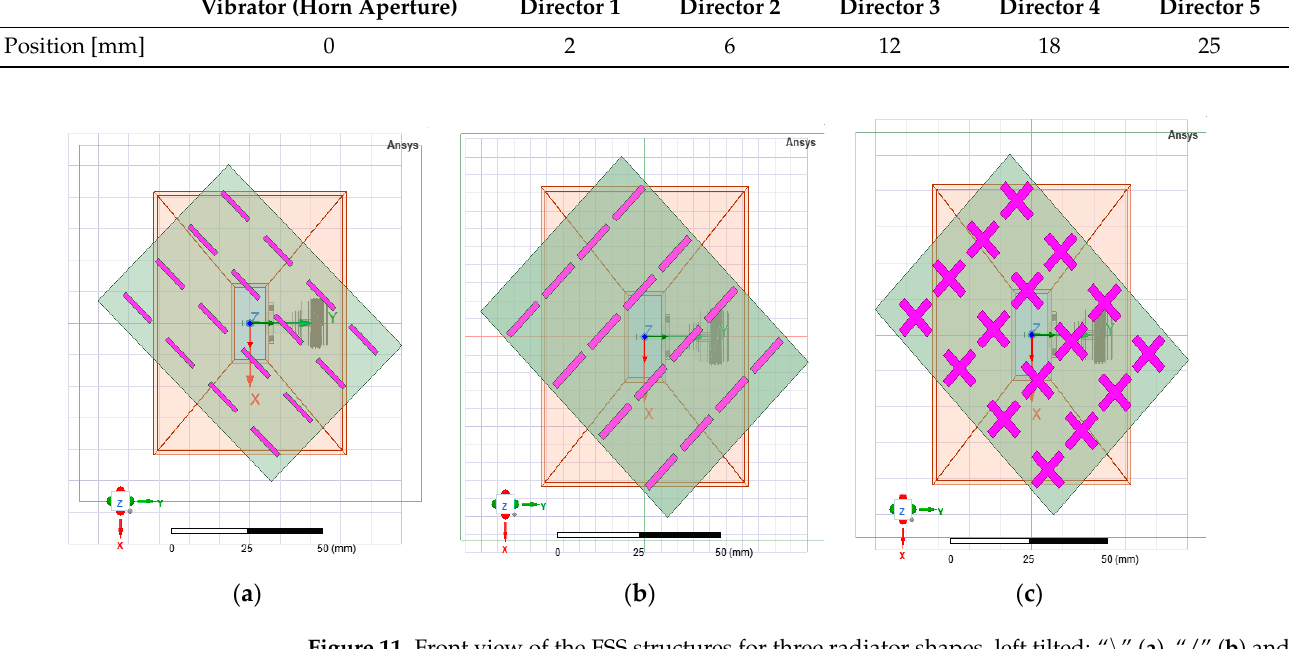
( f ) Figure 10. FSS structures with N × N elements in the aperture of the horn antenna. 3.2.2. Multiple-Layer FSS Structures The distances between successive layers were calculated in a similar manner to when designing a Yagi-Uda array, using a dedicated online calculator. The resulting distances between the five layers of the FSS structure are given in Table 2. Based on the analysis